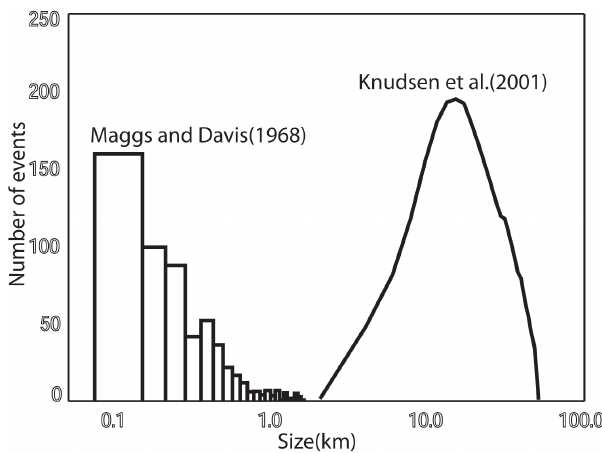
Fig. 1. Histograms of auroral arc widths as recorded by an all-sky imager (Knudsen et al., 2001) and a narrow FoV TV camera (Maggs and Davis, 1968). These histograms cover a very different scale size region due to the different instrumental specifications. The plot is according to Knudsen et al. (2001).